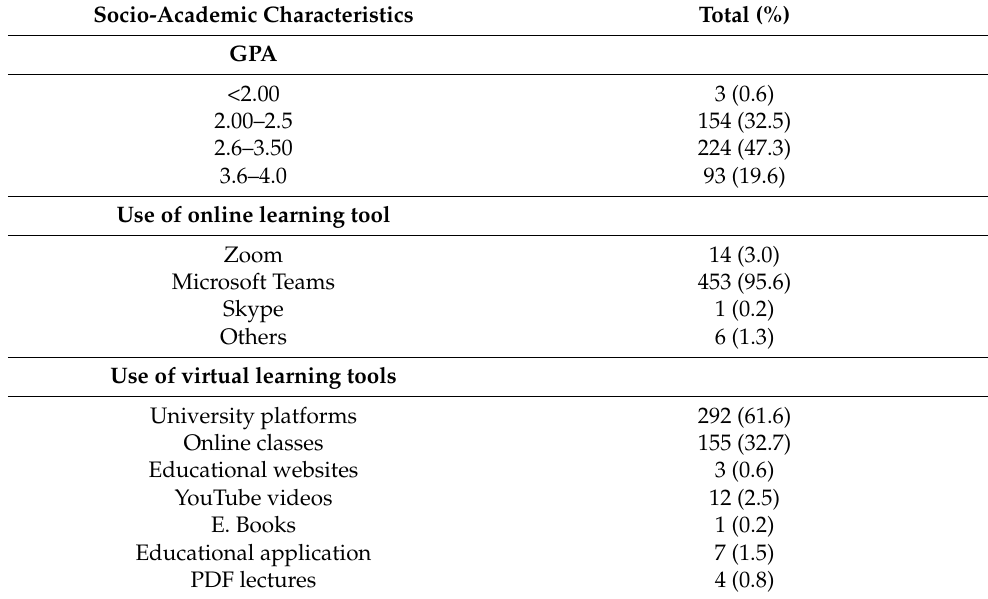
Table 3. GPA and used online tool.